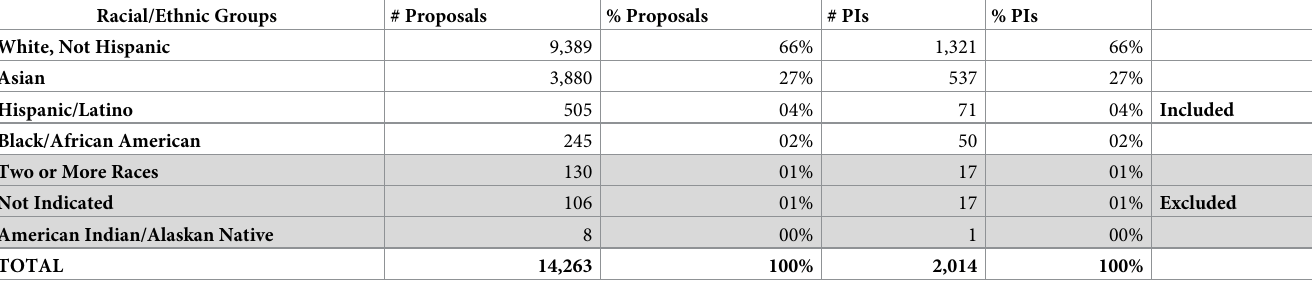
Table 1. UMMS racial/ethnic groups (2010–2022).